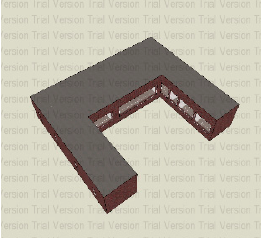
Table 2. Building envelope information of Rural House 2.